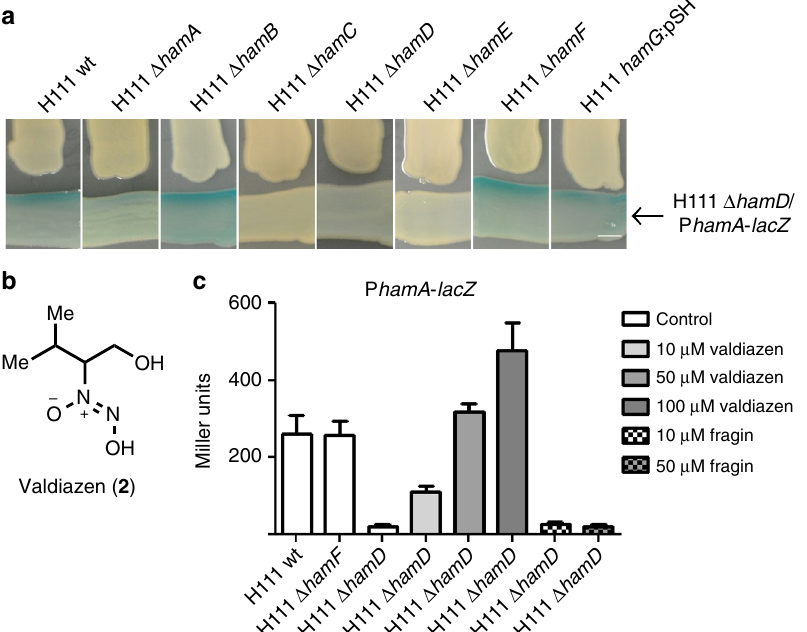
Fig. 5 A subset of the ham genes synthesize the signal molecule valdiazen. a Cross-streaks of all seven ham gene mutants against the reporter strain (H111 Δ hamD /P hamA - lacZ ) show that a subset of ham genes produces a diffusible signal molecule, which regulates ham promoter activity. The genes hamB , hamF , and hamG are dispensable for the production of the signal molecule. Scale bar indicates 5 mm. b Structure of valdiazen ( 2 ). c The promoter activity of the hamABCDE operon (P hamA - lacZ ) was comparable in the wild-type strain (H111 wt) and the hamF mutant strain (H111 Δ hamF ). The hamD mutant strain (H111 Δ hamD ) showed only very low promoter activity, which could be activitated by the addition of synthetic valdiazen. Results are presented as mean and error bars represent SD. n = 6 (H111 Δ hamF , H111 Δ hamD 10 μ M and 50 μ M valdiazen), n = 8 (H111 wt, H111 Δ hamD 100 μ M valdiazen), n = 9 (H111 Δ hamD 10 μ M and 50 μ M